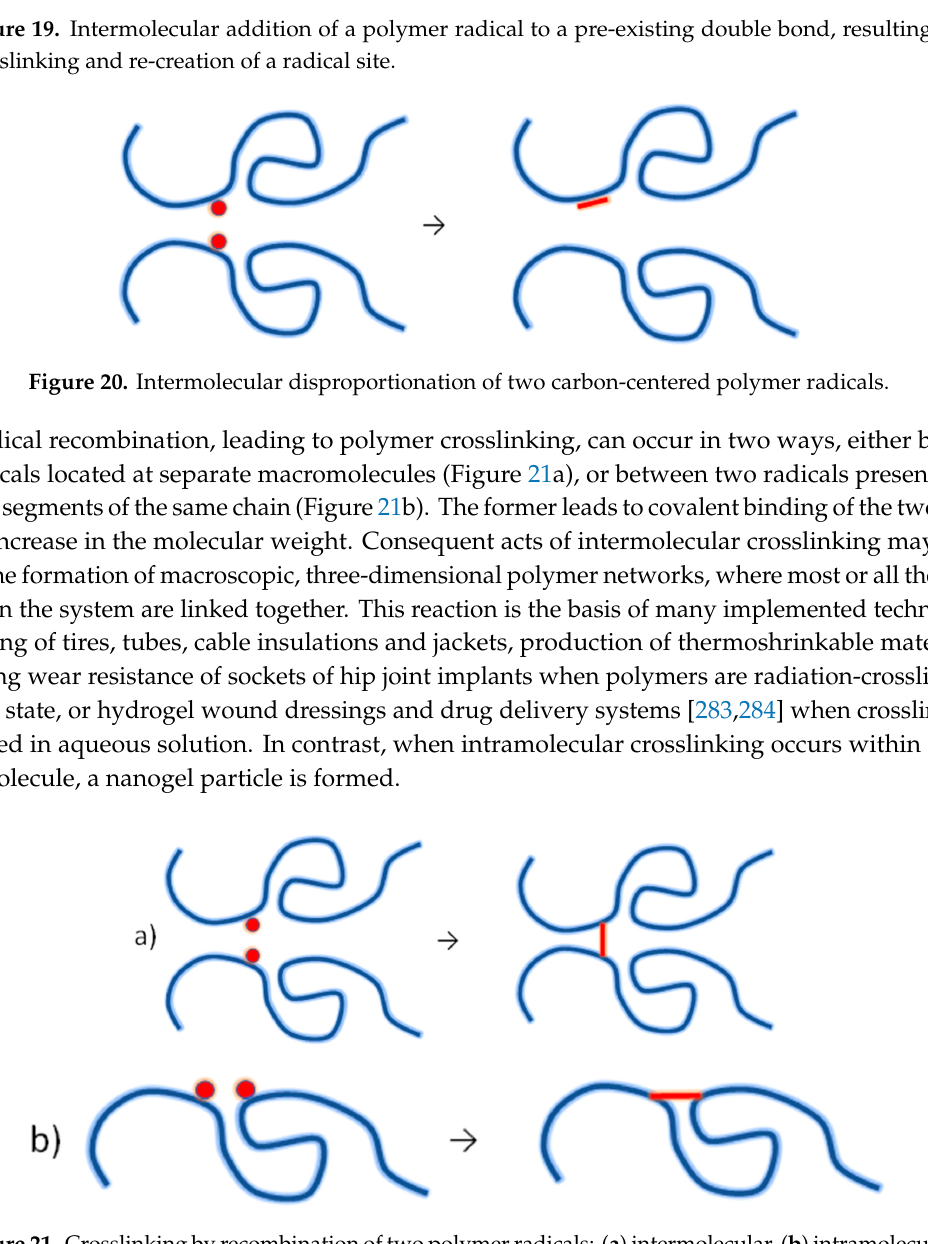
Figure 19. Intermolecular addition of a polymer radical to a pre-existing double bond, resulting in crosslinking and re-creation of a radical site. Polymers 2020 , 12 , x